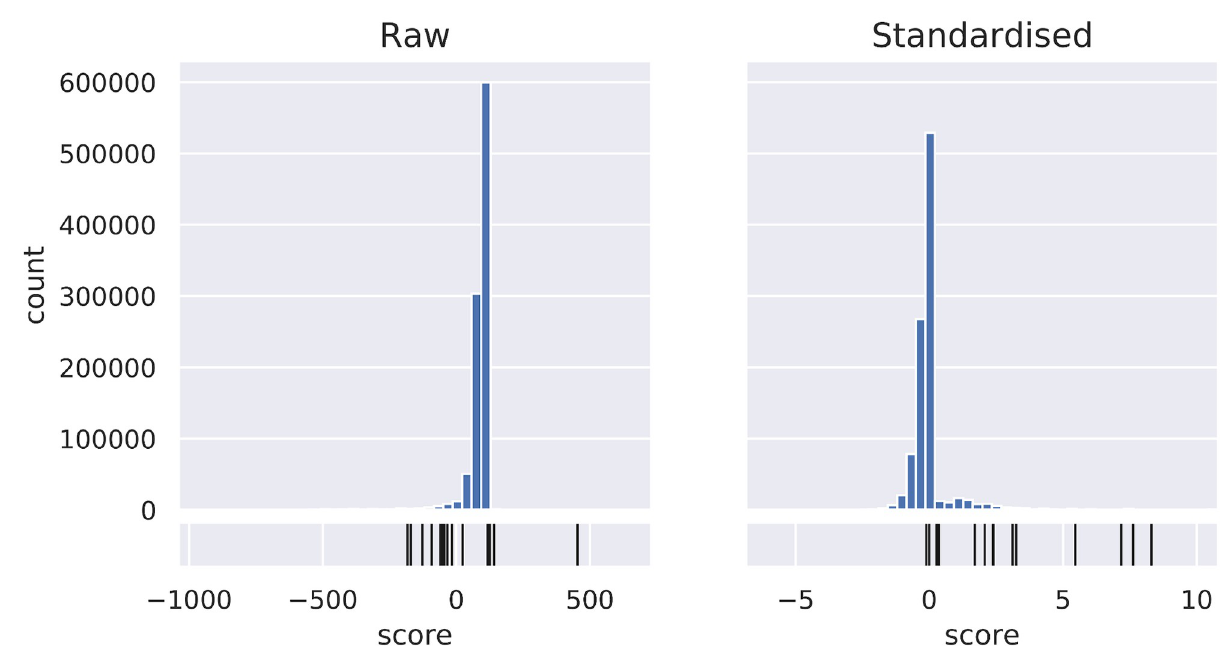
Fig 5. Distribution of validated links among scores. Distribution of the raw and standardised strain correlation scores, as well as the distribution of the scores for validated links (in black) relative to the distribution of scores for all links, in the Cru¨semann data set. The standardised score has a more pronounced tail at the top end, which includes 13 out of 15 validated links, whereas many of the validated links score relatively low on the distribution of the raw scores. Figures for other data sets can be found in S1 Fig.